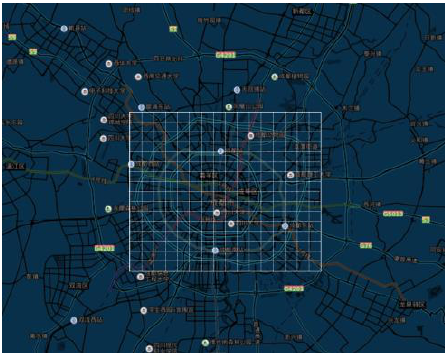
Figure 6. The Chengdu Fourth Ring Region is divided into 256 areas.